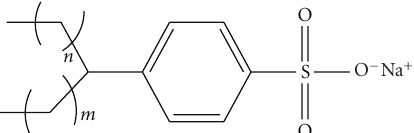
Scheme 1: Chemical structure of LAS inhibitor, n + m = 7–10 methyl